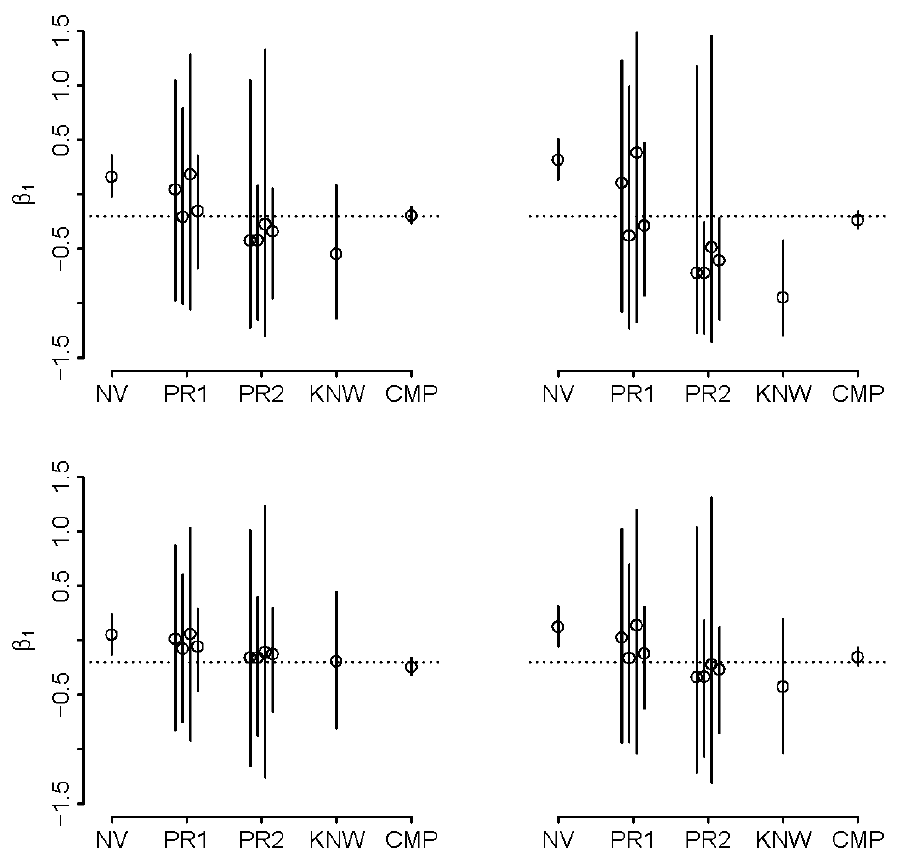
Figure 4. Adjusted estimates of β 1 with different degrees of knowledge about joint distribution of duration and intensity of exposure when ρ = −0.5 and k = 2.6 in four simulations of synthetic example; naïve estimate (NV) is contrasted with adjusted estimates obtained under “well-calibrated” priors on (ρ,k) that are “wide” (PR1), “narrow” (PR2), estimates obtained with ρ and k known (KNW; the best one can do without complete data), and complete data on intensity and duration (CMP); true value is denoted by dotted line, solid lines represent 95% credible intervals; see text for details.